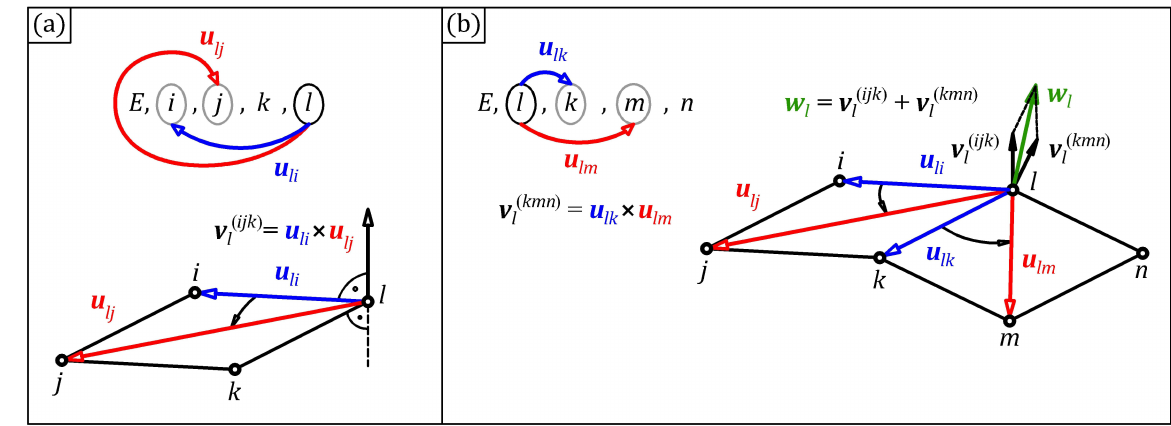
Figure 4: The method of determining vectors. (a) the normal vector for a four-node surface element E , i , j , k , l in node l , (b) the vector indicating replication direction of node l for two adjacent